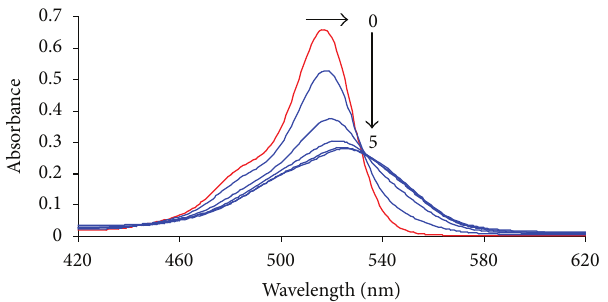
Figure 5: Fluorescence quenching of FN ( 5×10 −6 M; red color) with colloidal SnO 2 ( 0 – 5 × 10 −4 M; blue color) in